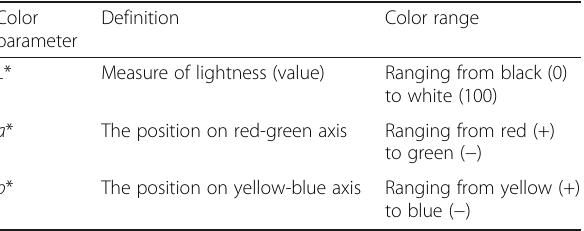
Table 1 CIE color system Color parameter